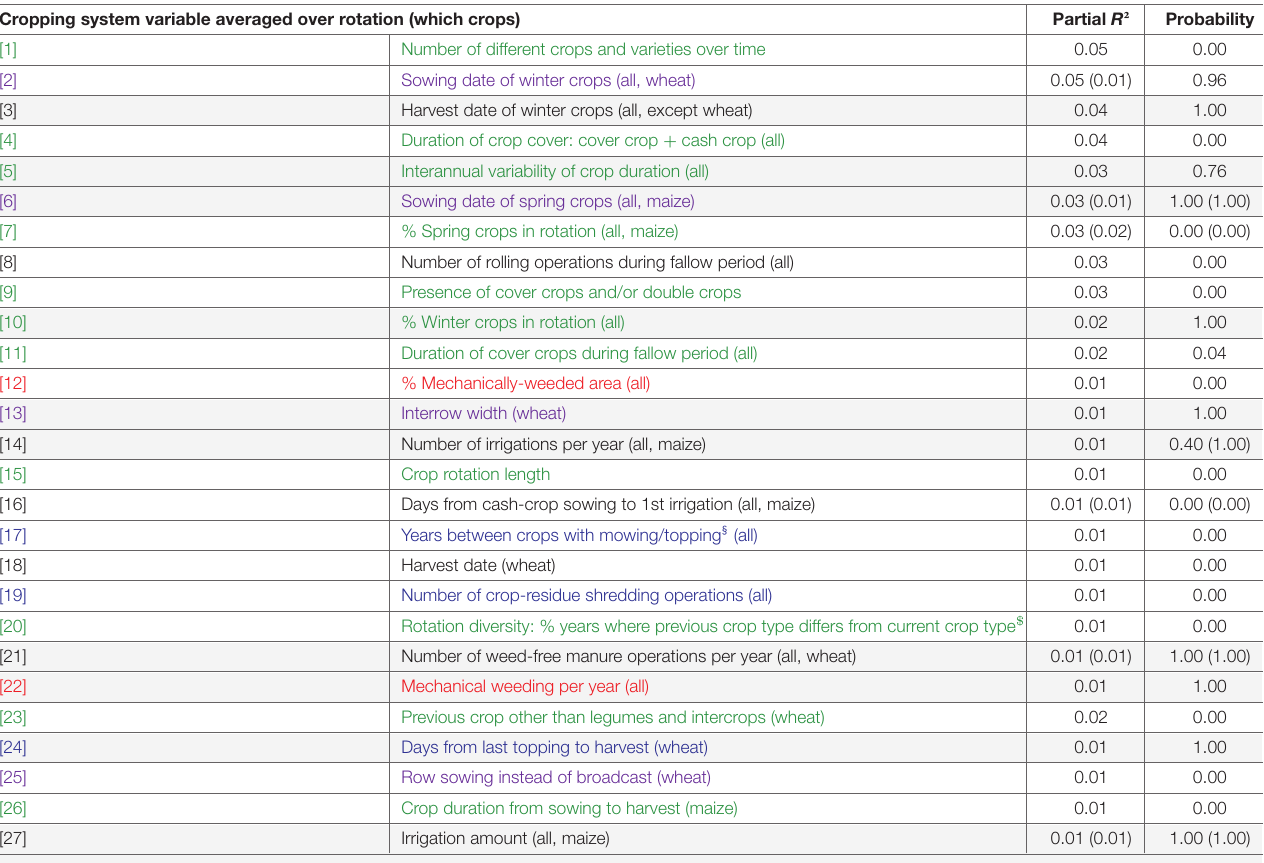
TABLE 6 | The main cropping-system components (other than those related to tillage and herbicide strategies) that are associated with a reduction in tillage, in herbicide use intensity and/or in grain yield loss due to weeds. Results from multi-variate classification and regression tree analyzing grain yield loss, number of tillage operations per year and herbicide treatment frequency as a function of cropping system characteristics using all three simulation series (with recorded systems, after tillage deletion, after herbicide deletion), with partial R ² calculated from Variable Importance Predictors and showing the probability that an increase in a cropping-system variable is associated to an increase in the mean of the three response variables [normed to (0 = lowest value in data set, 1 = highest value in data set)]. Cropping-system variables with a higher-than-average probability of increased response variable are shaded. The lower the partial R ² was, the more the effect of a variable was local (i.e., it depended on other cropping system variables). Variable colors distinguish rotation (green), mechanical weeding (brown), sowing (purple), crop-residue shredding, mowing and topping (blue), and other (black). The complete table can be found in Section The cropping practices that drive grain yield loss in no-till systems in Supplementary Material